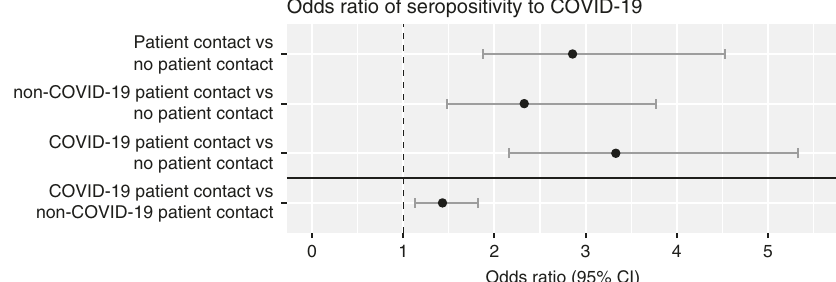
Fig. 3 Association between occupational exposure and seroprevalence of SARS-CoV 2 IgG antibodies. Odds ratios of seropositivity given patient contact, non-COVID-19 patient contact, or COVID-19 patient contact compared to no patient contact, and (under the horizontal black line) given COVID- 19 patient contact compared to non-COVID-19 patient contact. Odds ratios were calculated using two-sided Fisher ’ s exact test with n = 2149 (patient contact vs no patient contact), n = 1107 (non-COVID-19 patient contact vs no patient contact), n = 1267 (COVID-19 patient contact vs no patient contact), and n = 1764 (COVID-19 patient contact vs non-COVID-19 patient contact) independent individuals. No adjustment for multiple comparisons was applied. Data are presented as odds ratios and 95% con fi dence intervals. Source data are available as Source Data fi